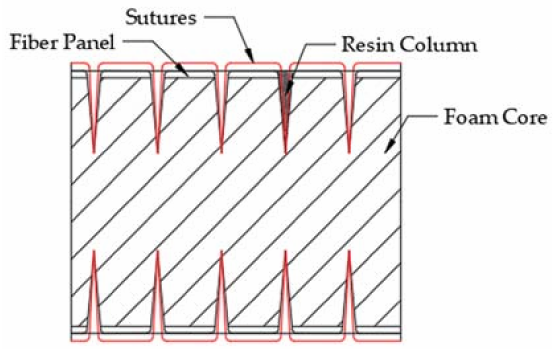
Figure 2. Schematic of the GFRP/foam sandwich composite suture profile